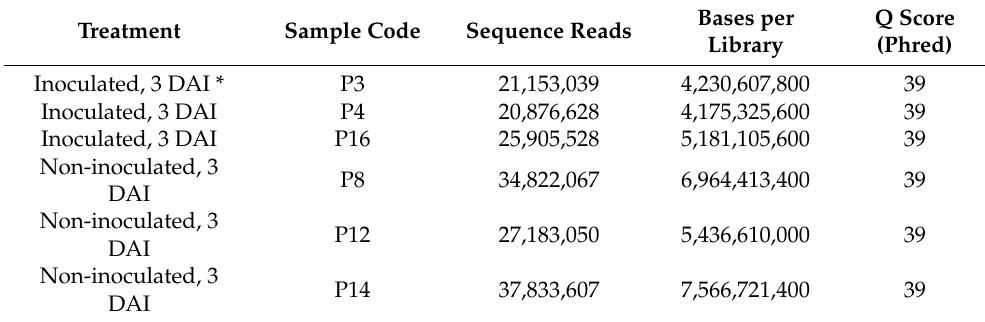
Figure 1. Growth of Pseudocercospora musae 15 EB on the abaxial surface of leaf areas in Musa acuminata Cavendish Grande Naine over a 28-day period during interaction with the pathogen. Images were obtained using confocal microscopy and staining for fungal chitin. ( A ). Hyphae colonizing leaf tissues at 6 DAI (magnification 10 × ). ( B ). Hyphal growth around stoma (white arrow) at 6 DAI (magnification 20 × ). ( C ). P. musae sporodochia emerging from colonized stomata (white arrows) at 28 DAI (magnification 10 × ). ( D ). Modified image C revealing only P. musae hyphae (magnification 10 × ). Table 1. Summary of filtered Illumina HiSeq 4000 sequence data statistics for each Musa acuminata var. Calcutta 4 cDNA